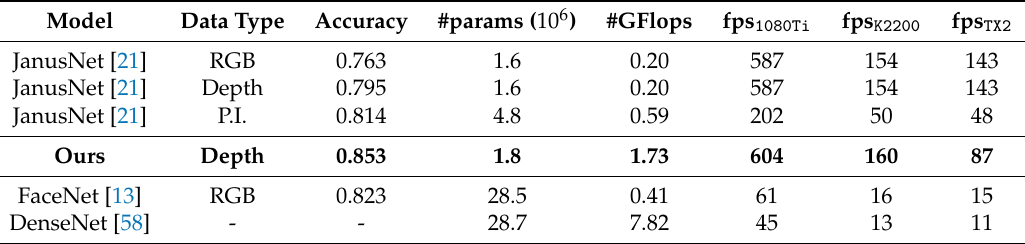
Table 3. Face verification accuracy on the Pandora dataset using the fixed test set, along with the computational requirements and the inference time, expressed as processed frames per second (fps). The proposed model is compared with every version of JanusNet [21], i.e., with different training data: only RGB, only depth, and both using the Privileged Information (P.I.) approach. We also report the performance of a FaceNet -like architecture for